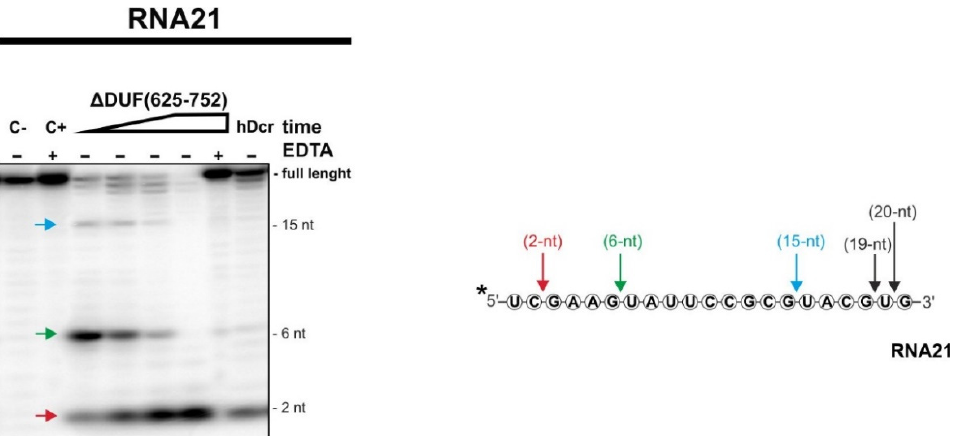
Figure 4. The results of the RNA-cleavage assays involving 21-nt RNA. Reaction mixtures were incubated for 10, 30, 60, 120 min for ∆ DUF(625-752) (increasing time is represented by a triangle) with 18 nM of protein. (C-) control containing only the substrate in the reaction buffer. (C+) controls incubated without a protein but with 25 mM EDTA. Additional control reaction included the substrate and 18 nM hDicer protein (hDcr) incubated for 120 min. (+EDTA) supplementation of the reaction buffer with 25 mM EDTA. The asterisk indicates the 32 P 5 (cid:48) -end label. The reproducible results were obtained using at least two batches of recombinant ∆ DUF(625-752) and